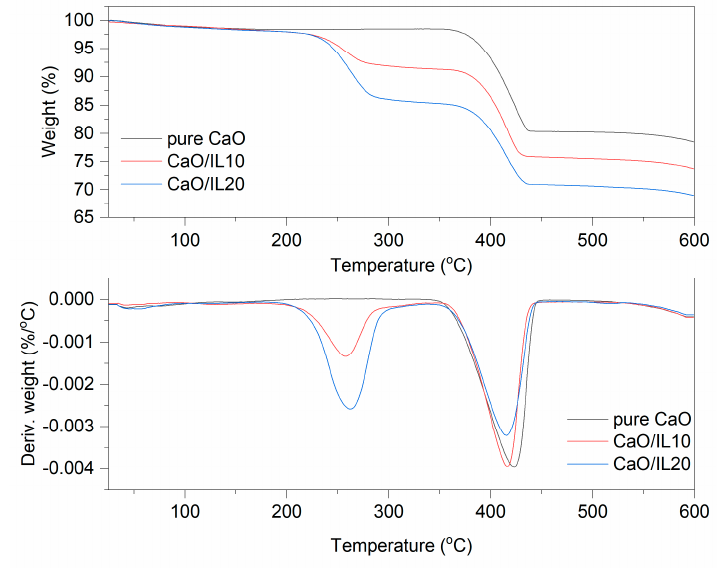
Figure 5. TG and DTG curves for pure and DmiBr-modified nanosized CaO.